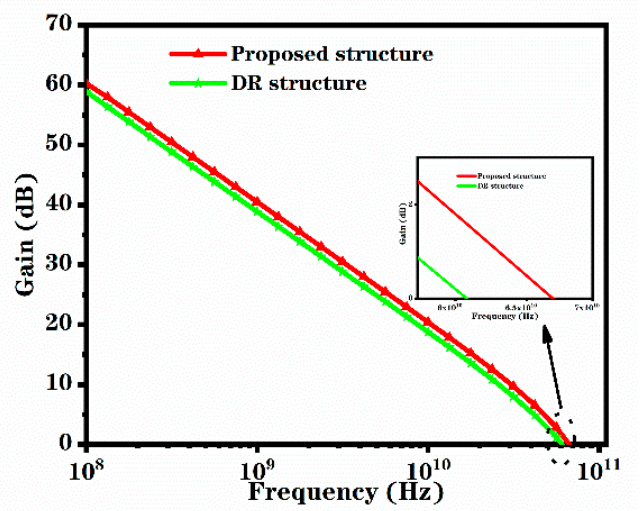
Figure 8. Relationship between unilateral power gain and frequency for the proposed structure and DR structure at V gs = 0 V and V ds = 40 V.